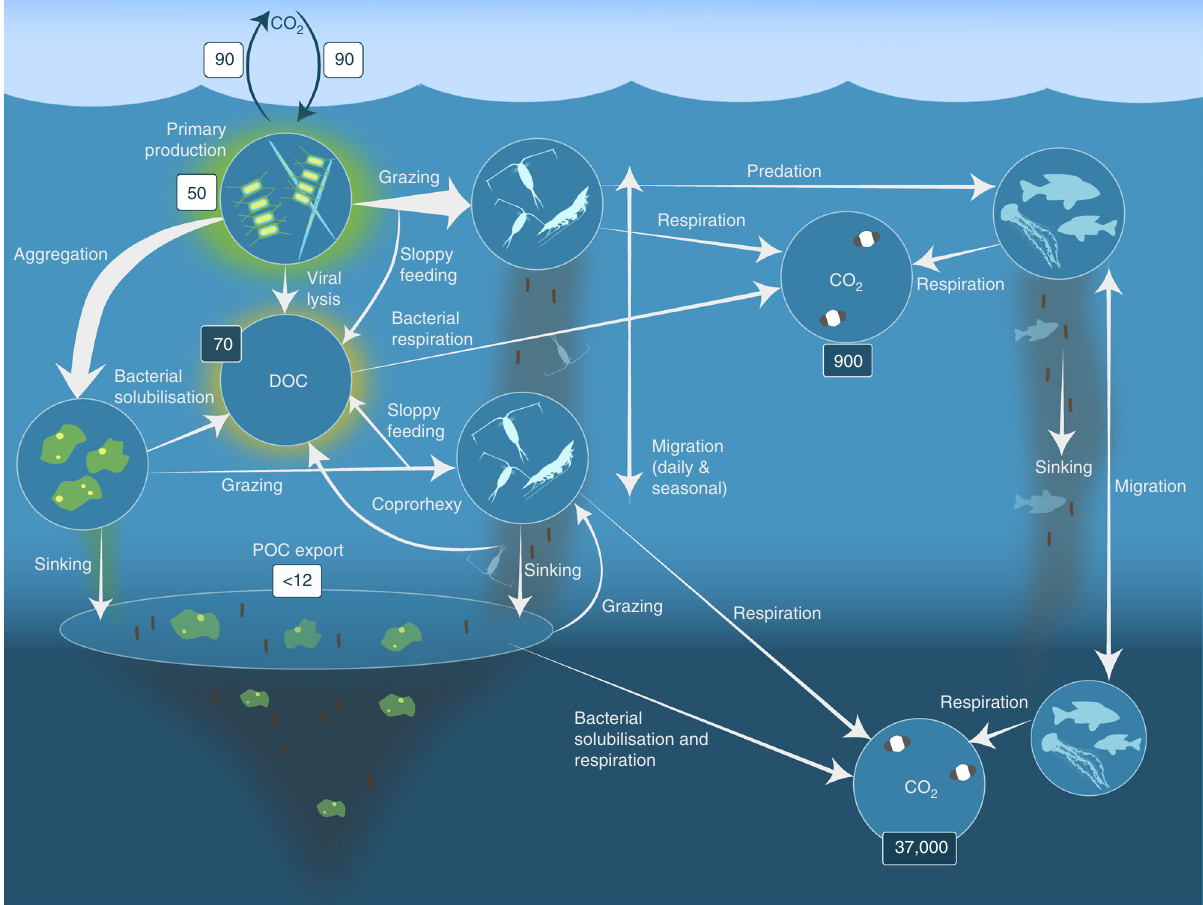
Fig. 1 Processes in the biological pump. Phytoplankton convert CO 2 , which has dissolved from the atmosphere into the surface oceans (90 Gt yr − 1 ) into particulate organic carbon (POC) during primary production (~ 50 Gt C yr − 1 ). Phytoplankton are then consumed by krill and small zooplankton grazers, which in turn are preyed upon by higher trophic levels. Any unconsumed phytoplankton form aggregates, and along with zooplankton faecal pellets, sink rapidly and are exported out of the mixed layer (< 12 Gt C yr − 1 14 ). Krill, zooplankton and microbes intercept phytoplankton in the surface ocean and sinking detrital particles at depth, consuming and respiring this POC to CO 2 (dissolved inorganic carbon, DIC), such that only a small proportion of surface- produced carbon sinks to the deep ocean (i.e., depths > 1000 m). As krill and smaller zooplankton feed, they also physically fragment particles into small, slower- or non-sinking pieces (via sloppy feeding, coprorhexy if fragmenting faeces), retarding POC export. This releases dissolved organic carbon (DOC) either directly from cells or indirectly via bacterial solubilisation (yellow circle around DOC). Bacteria can then remineralise the DOC to DIC (CO 2 , microbial gardening). Diel vertically migrating krill, smaller zooplankton and fi sh can actively transport carbon to depth by consuming POC in the surface layer at night, and metabolising it at their daytime, mesopelagic residence depths. Depending on species life history, active transport may occur on a seasonal basis as well. Numbers given are carbon fl uxes (Gt C yr − 1 ) in white boxes and carbon masses (Gt C) in dark